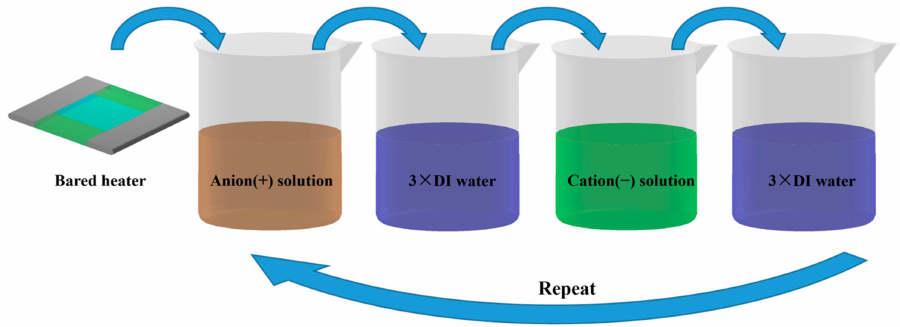
Figure 12. The LbL dipping